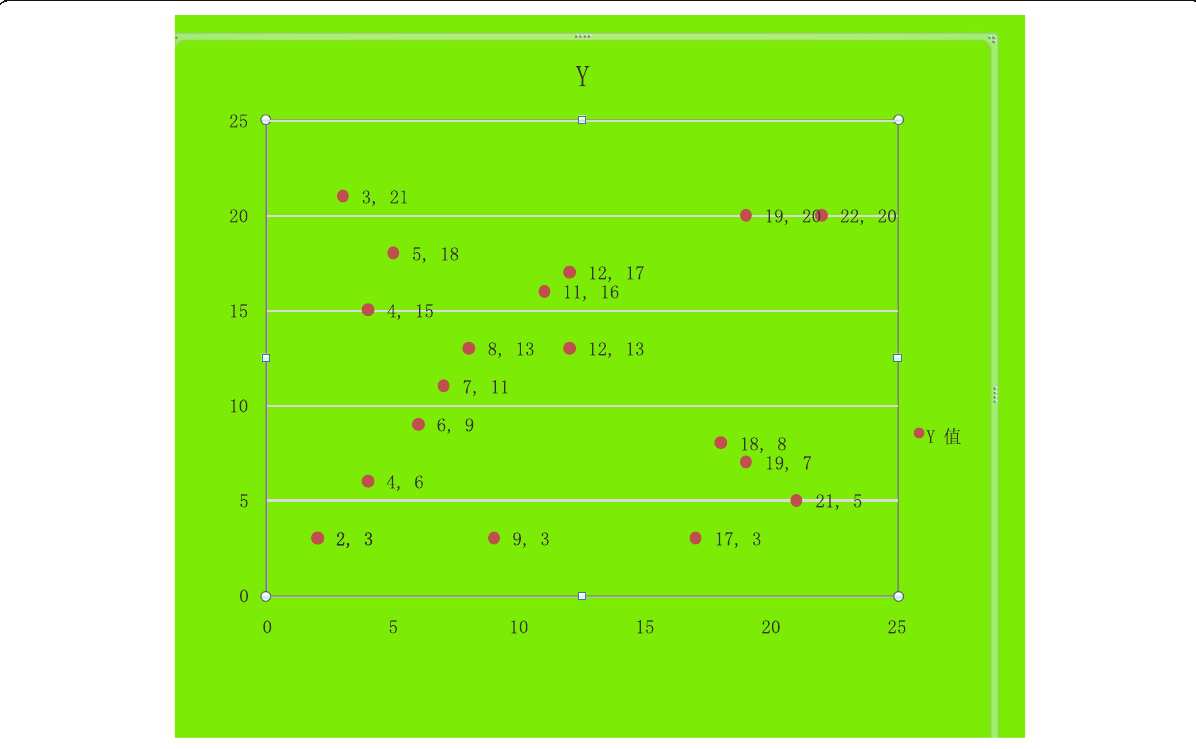
Fig. 2 Distribution of transport demand